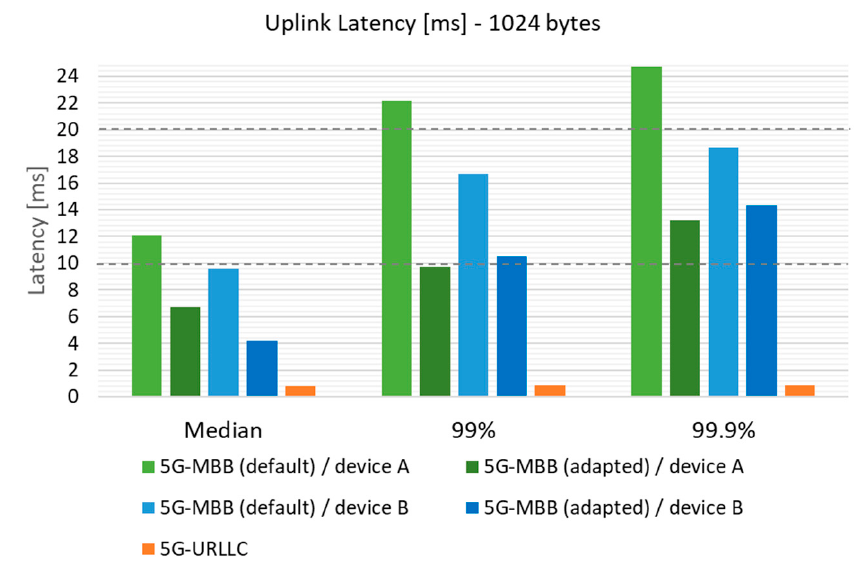
Figure 7. Uplink latency for 1024-byte messages and different reliability percentiles (median, 99th percentile, 99.9th percentile).